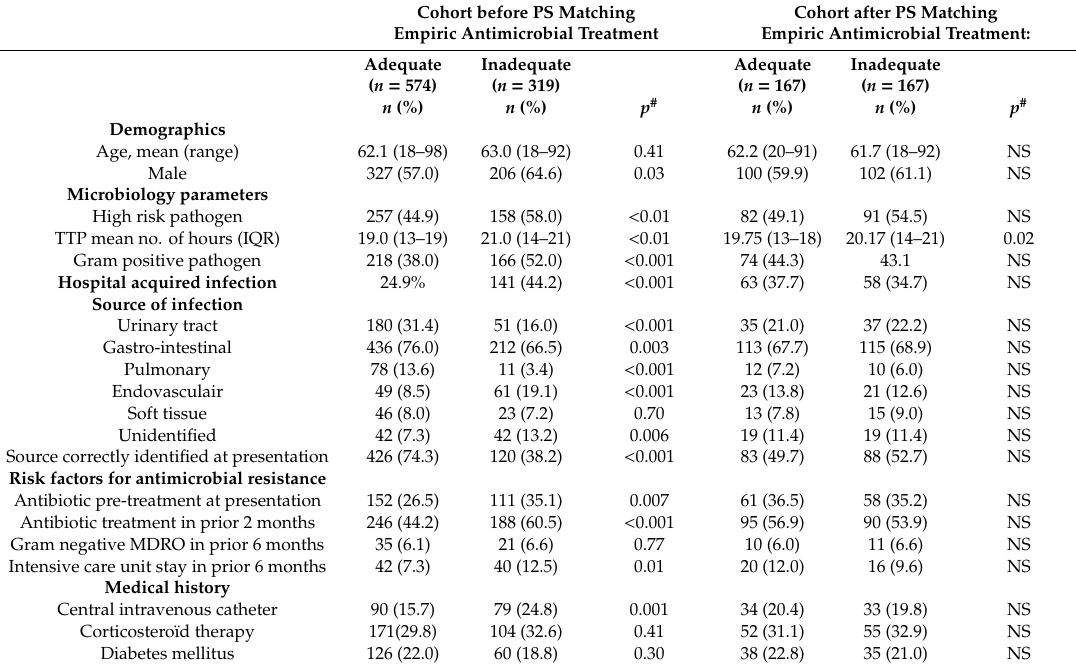
Table 1. Cohort characteristics before and after propensity score (PS) matching. Cohort before PS Matching Cohort after PS Matching Empiric Antimicrobial Treatment Empiric Antimicrobial